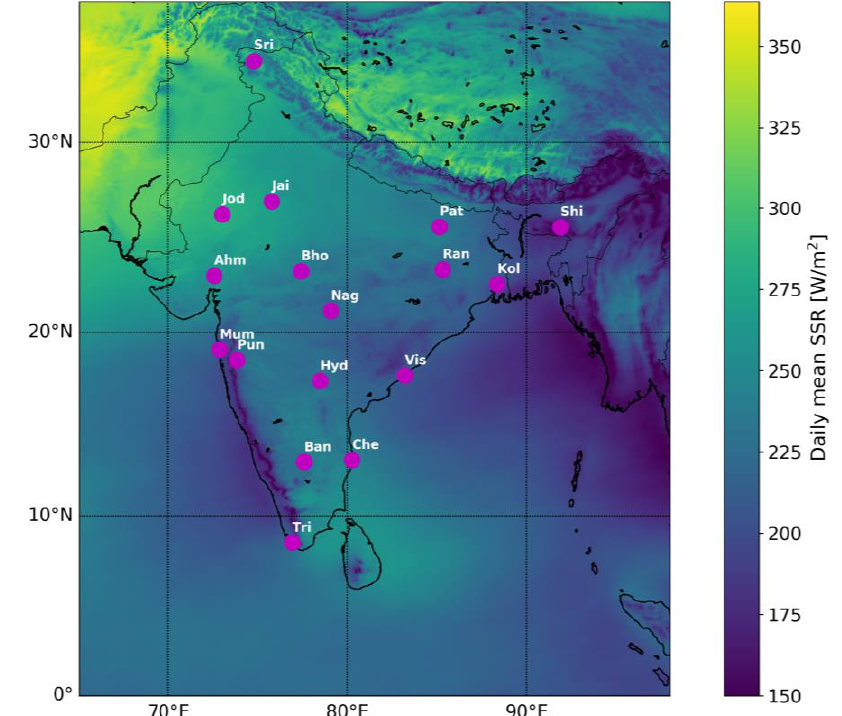
Figure 1. June mean SSR during 1999–2015 over the Indian subcontinent from SARAH-E data. Validation site locations shown with circular markers and partial site names. Decreased SSR along the western seaboard reflects the intense coastal cloudiness of the monsoon season.